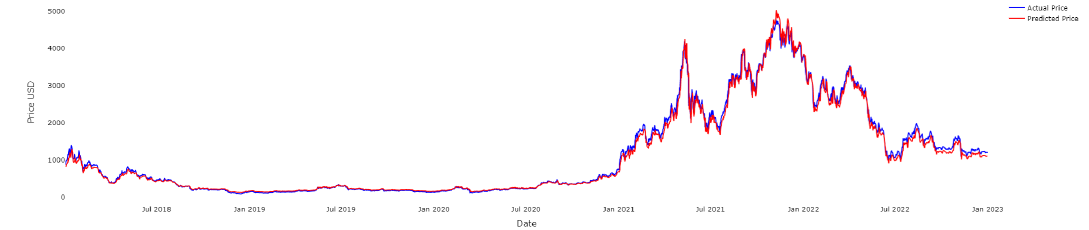
Figure 16. ETH—actual and predicted results using the LSTM model.